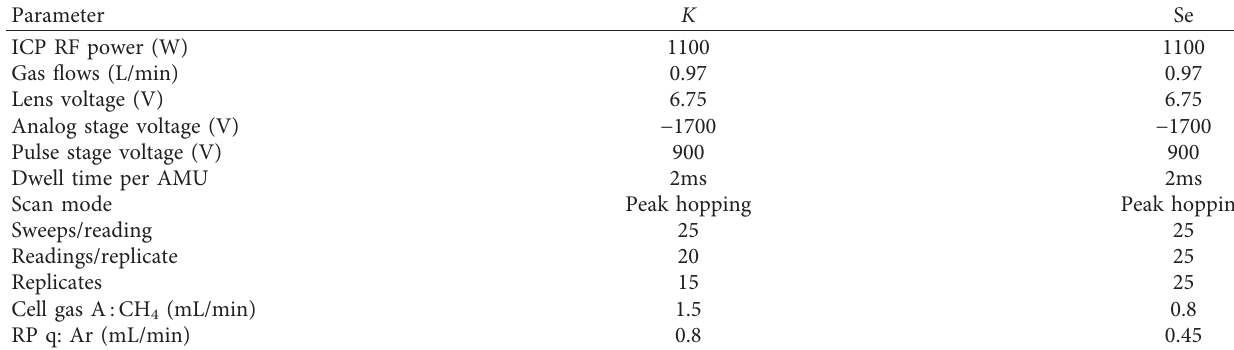
Table 1: Instrument